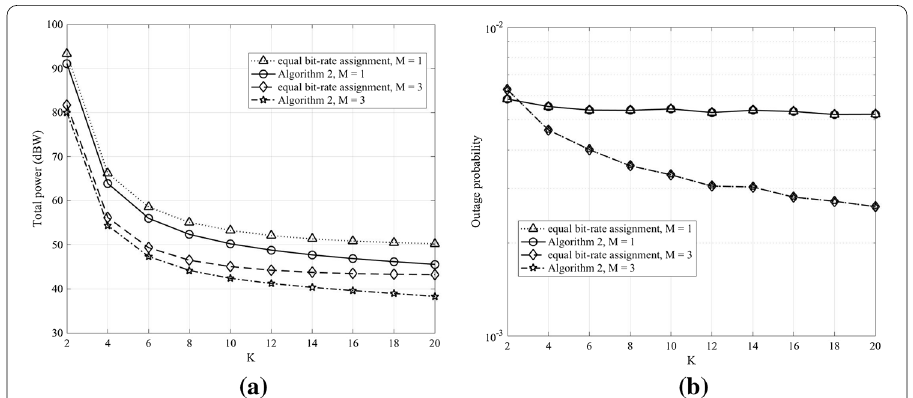
Fig. 6 Total transmit power and outage probability versus K , where r = 10bit/s/Hz , d AR = 0.5 and Q out = 0.01